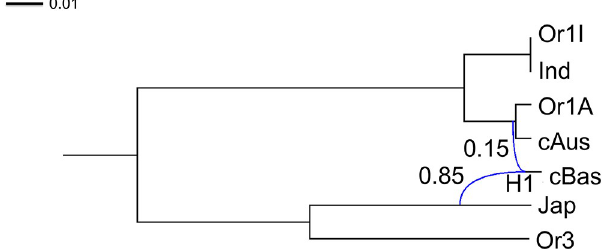
Fig 17. The MAP phylogenetic network obtained for data set 3 with two varieties per subpopulation. Inheritance probabilities are reported above reticulation edges and branch lengths are given in units of expected number of mutations per site (see the scale at the top